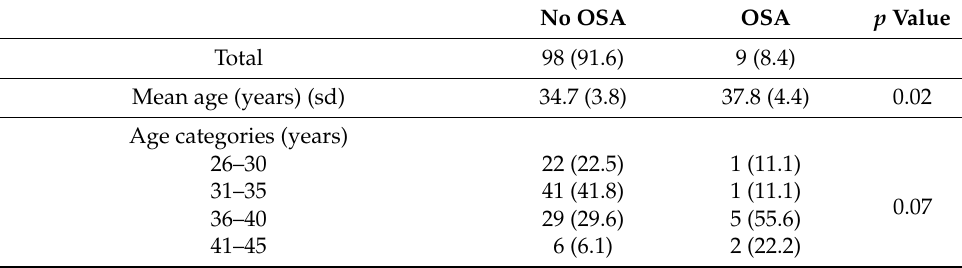
Table 1. Comparison of demographics of participants screening positive versus negative for